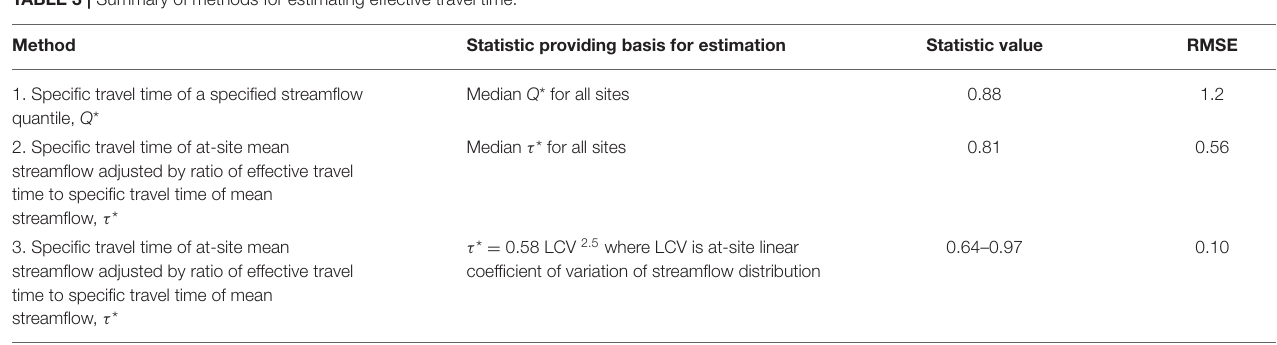
TABLE 3 | Summary of methods for estimating effective travel